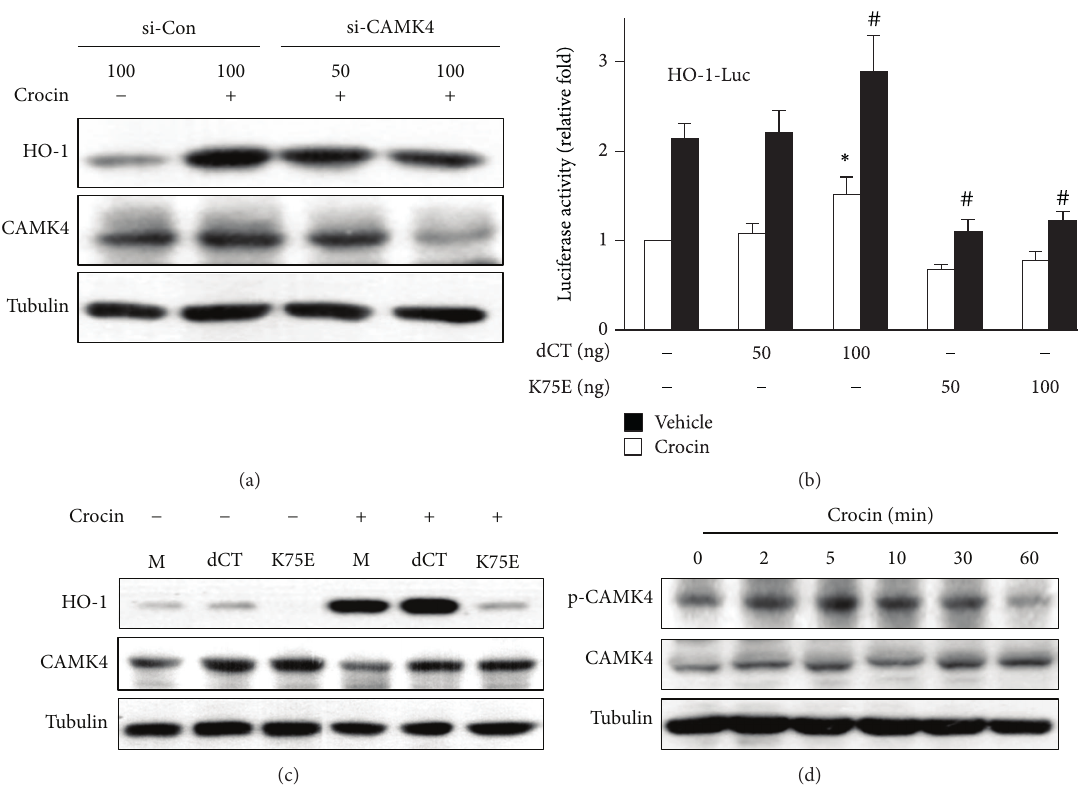
Figure 6: Involvement of CAMK4 in crocin-mediated expression of HO-1. (a) RAW 264.7 cells were transfected with CAMK4 siRNA or control siRNA and then treated with crocin (500 𝜇 M) for 6h. Equal amounts of cytosolic proteins were analyzed by Western blotting. (b) Cells were cotransfected with HO-1 promoter-luciferase construct and pcDNA3.1, CAMK4 constitutive active (dCT), or kinase dead (K75E) construct and then treated with crocin (500 𝜇 M). Equal amounts of cell extracts were assayed for dual luciferase activity. ∗ 𝑃 < 0.05 versus the pcDNA3.1-transfected (vehicle-treated) group; # 𝑃 < 0.05 versus the pcDNA3.1-transfected (crocin-treated) group. (c) Cells were transfected with pcDNA3.1 (mock, M), dCT or K75E construct and then treated with crocin (500 𝜇 M). Equal amounts of cytosolic proteins were analyzed by Western blotting. (d) Cells were treated with crocin (500 𝜇 M) for the indicated time and the levels of phosphorylated CAMK4 and total CAMK4 were analyzed by Western blotting. Tubulin was used as a loading